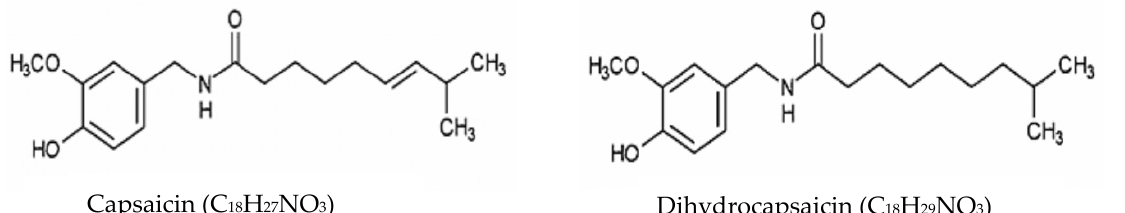
Figure 3. Chemical structure of capsaicin and dihydrocapsaicin [54]. Copyright: Journal Cancer Let- ters, 2001.